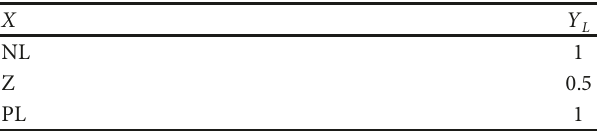
Table 2: The fuzzy rules of the system.